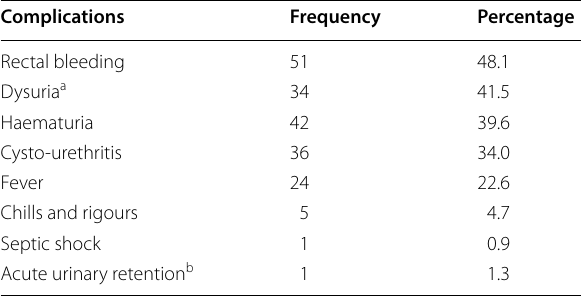
Table 3 Complications following prostate